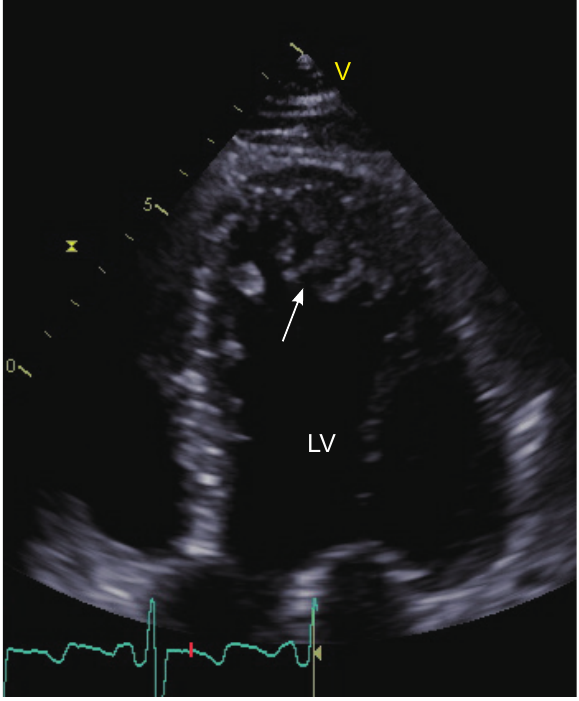
Figure 9 Echocardiography: the increase of ventricular trabeculae can be detected in left ventricular apex (indicated by the arrow).